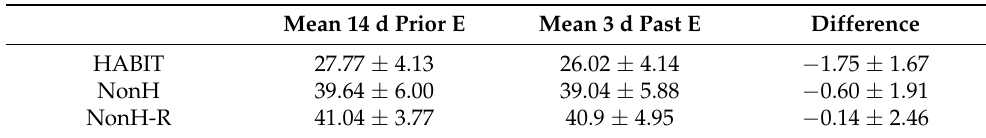
Table 2. Differences between the mean daily milk yield during the 14 days prior to evacuation and the mean daily milk yield (kg/d) during the three days past evacuation per